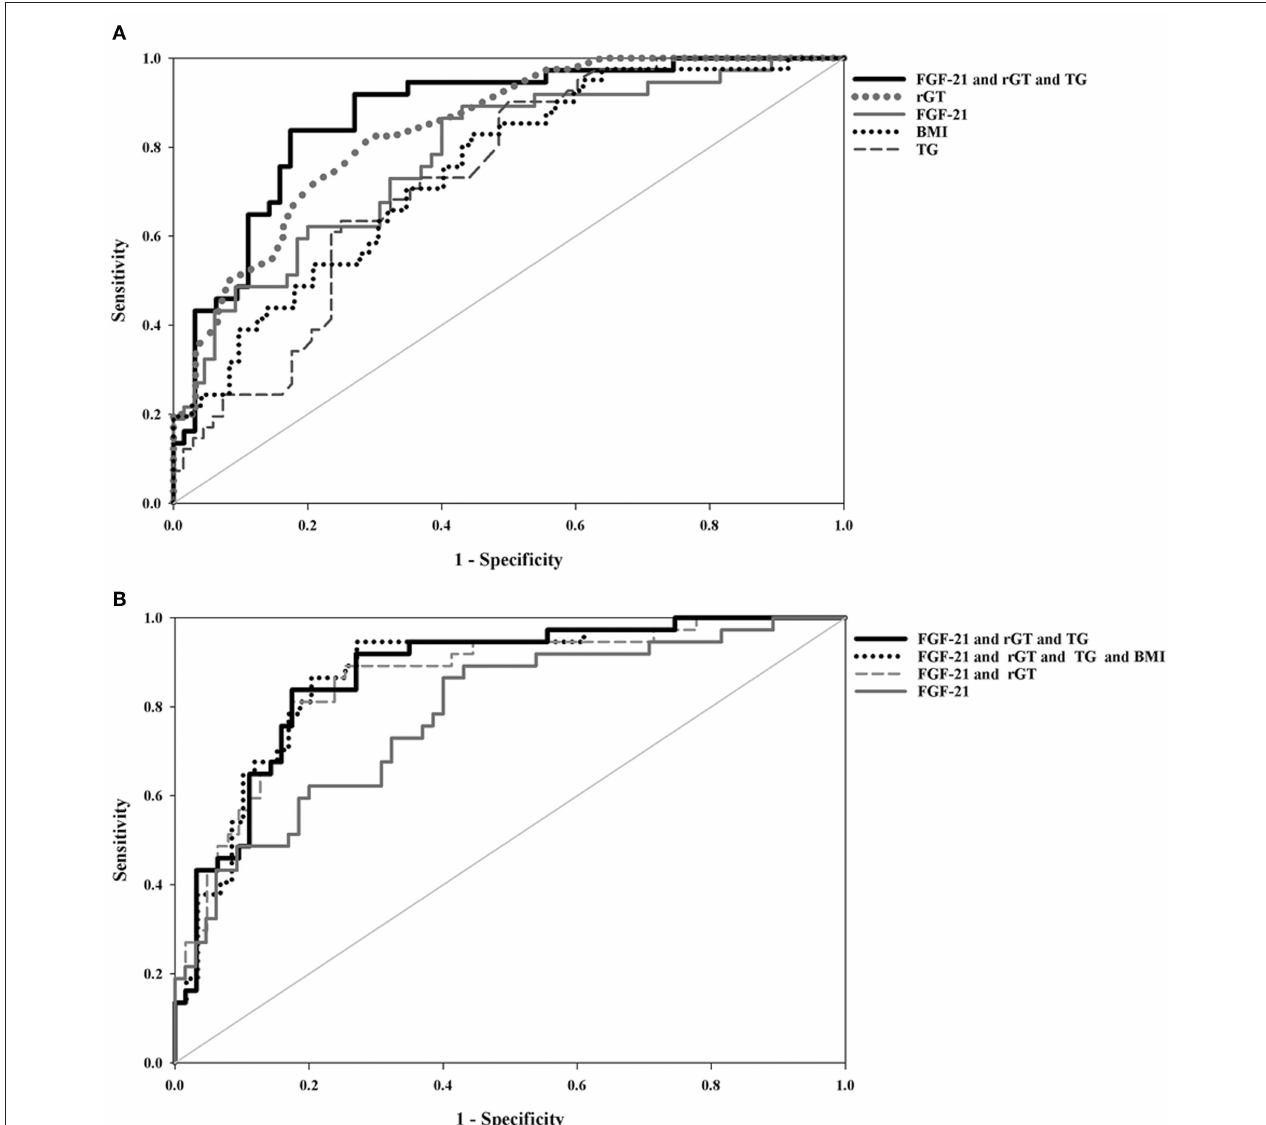
FIGURE 2 | Comparison of area under the receiver-operating characteristic(AUROC) curves between (A) single blood test and a combined biomarker panel (B) combined biomarker panels and FGF-21 for the prediction of high-grade liver steatosis in the obese and overweight subjects. All values were logarithmically transformed in the statistical